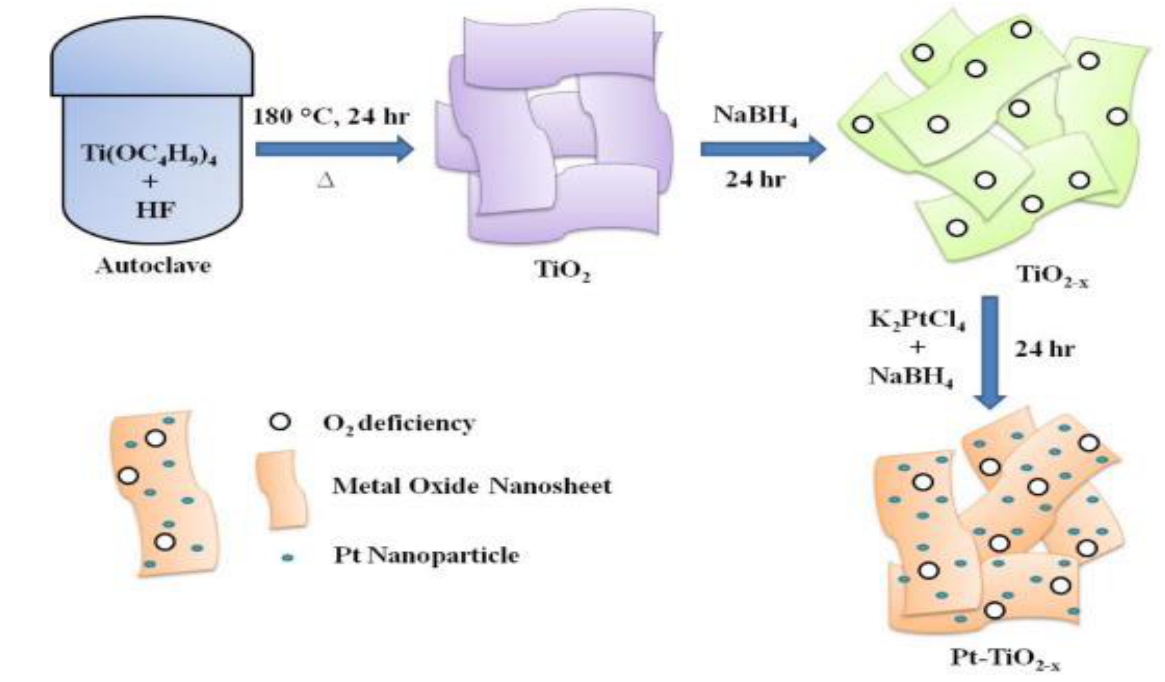
Figure 15. Schematic illustration of the preparation of Pt – TiO 2-x NS. Reprinted with permission from [140]. Copyright 2020 Elsevier.